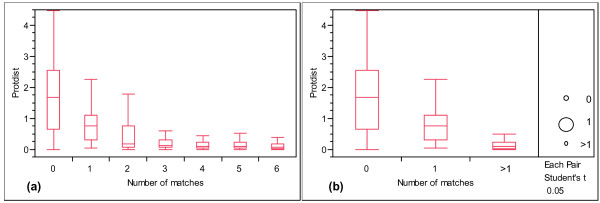
The box plot of Protdist in each level of local synteny. Local synteny is measured by the maximum number of unique homologous matches between 6 neighboring genes. (a) It shows a negative relationship between Protdist and the number of matches (r = -0.67 with p-value < 0.0001). (b) No match, one match and more than one match have significantly different Protdist means (Student's t test, p-value < 0.05). Protdist and the numbers of matches are calculated from the randomly sampled 1,000 cross-species homologous protein pairs (defined as belonging to the same Pfam families).